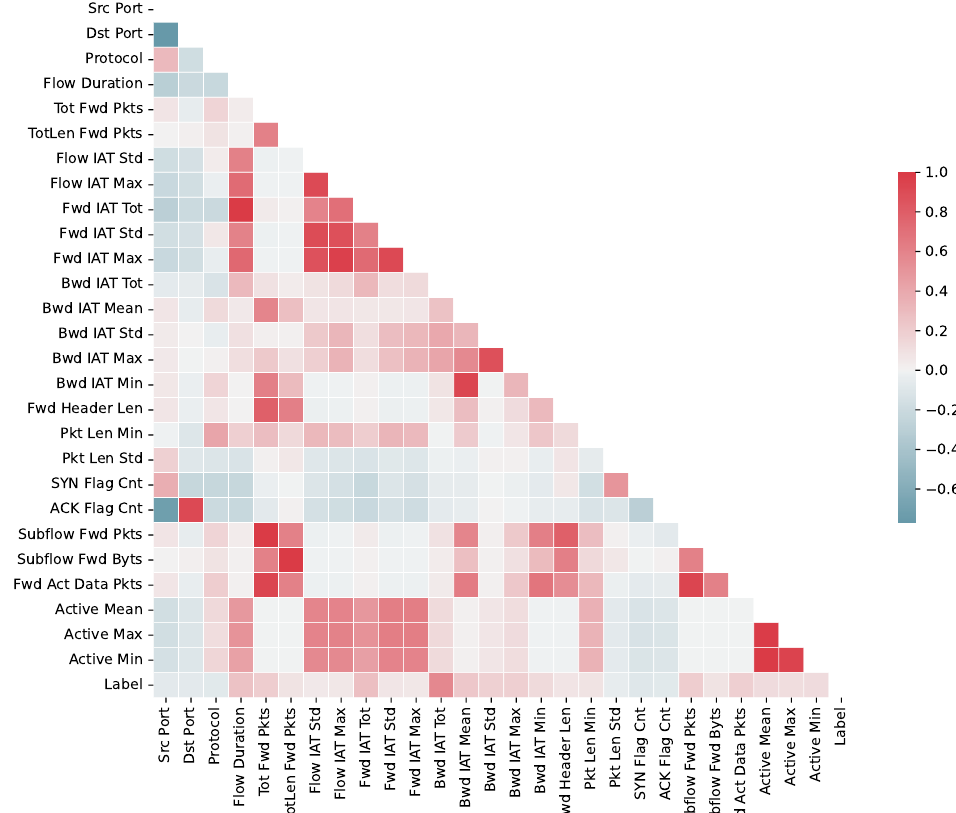
Figure 3. Pairwise correlation matrix of prepared dataset. Filtered according to level of correlation between label column and other parameters for feature selection purposes.